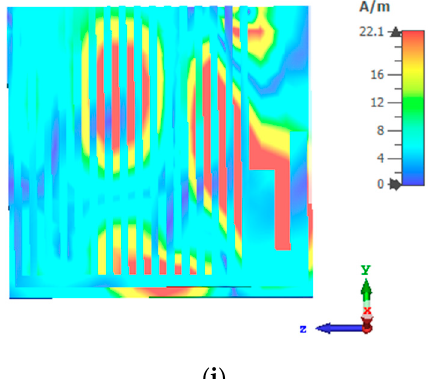
Figure 2. Electrical surface current distribution of each antenna at resonant frequencies. ( a ) 400 MHz, ( b ) 2.4 GHz, ( c ) 5.7 GHz, ( d ) 400 MHz, ( e ) 2.4 GHz, ( f ) 5.7 GHz, ( g ) 400 MHz, ( h ) 2.4 GHz, and ( i ) 5.7 GHz.